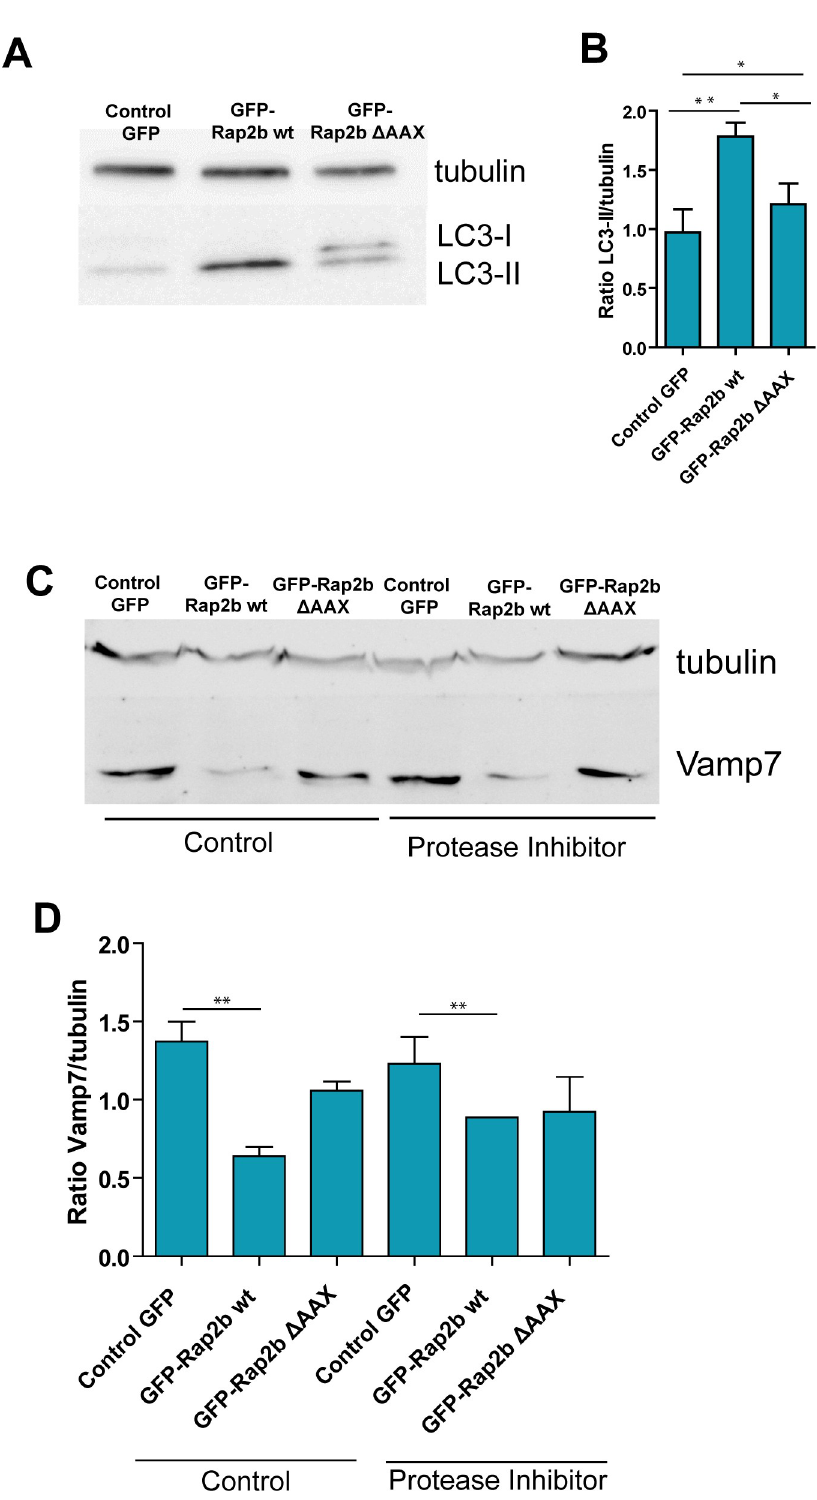
Fig 7. LC3 and Vamp7 are altered by overexpression of Rap2b wt in control and infected CHO cells. A. CHO cells were transfected with pEGFP, wt pEGFP-Rap2b or pEGFP-Rap2b Δ AAX. After 24 hours, cells were incubated with C . burnetii mCherry for 48 h (MOI = 10). Afterwards, cells were lysed with sample buffer and the samples were subjected to Western blot analysis using a rabbit anti-LC3 and the corresponding HRP-labeled secondary antibody,